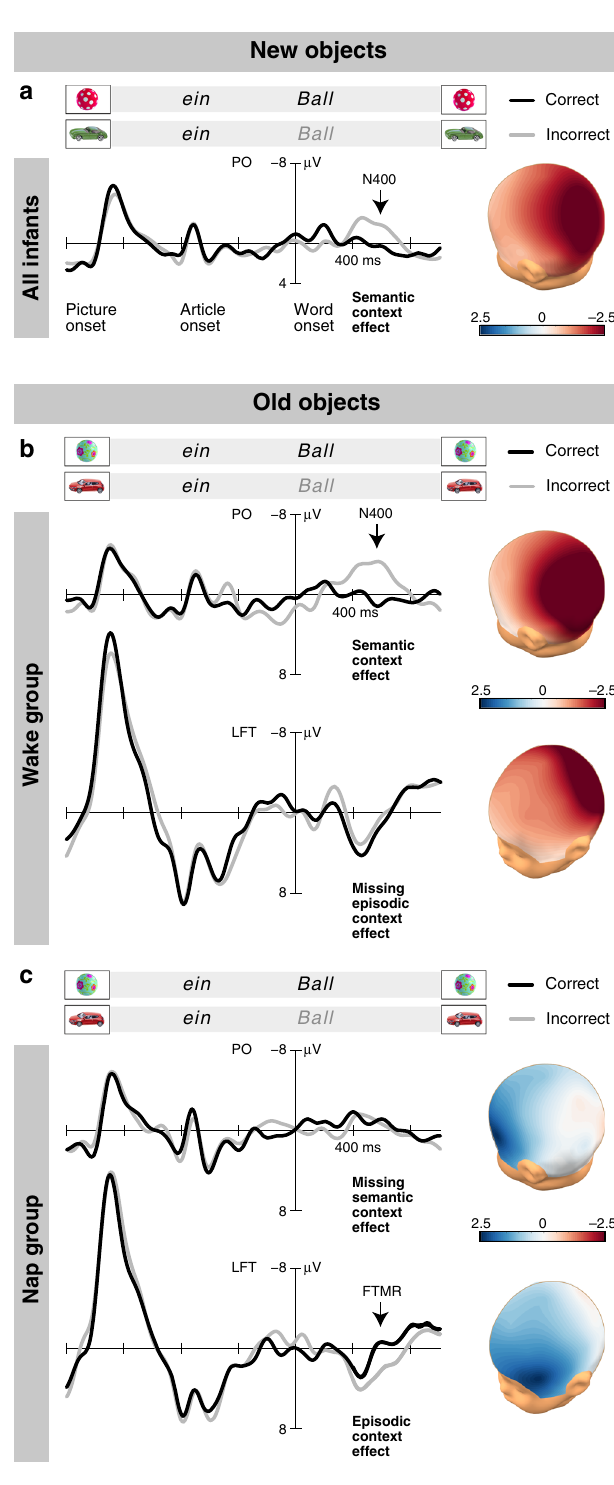
infants who nap after encoding, retain this information. Their memory for the episodic context of a word is the better, the higher the amplitude of their frontal fast sleep spindles during the post- encoding nap. Differences in the N400 between words paired with old objects and words paired with new objects reveal that, after the nap, the new memory for an episodic experience interferes with the semantic processing of that experience, a mechanism that might enable both precise retrieval and semantic re fi nement.